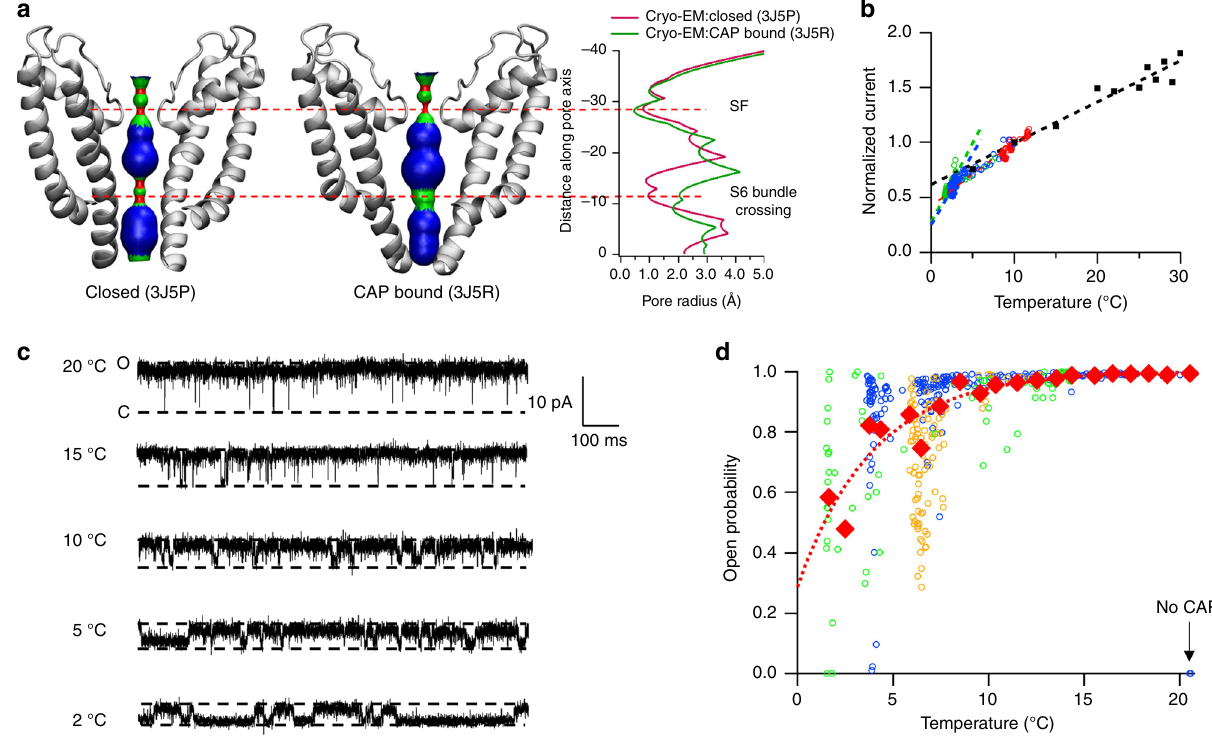
Fig. 1 TRPV1 closure induced by cooling in the presence of saturating concentrations of capsaicin. a Distribution of pore radii in the cryo-EM-derived closed state (3J5P) and capsaicin bound state (3J5R). The regions in red are too narrow to allow a water molecule to pass. The regions in green or blue are sites allowing single or multiple water molecules and ions to pass. Pore radii were calculated by the HOLE program 65 . SF, selectivity fi lter. b Temperature- dependent reduction of macroscopic current amplitude is steeper than that of single-channel conductance. Macroscopic currents from three inside-out patch recordings (shown in red, blue, and green) and single-channel current (shown in black) are normalized to the amplitude at 10 °C. Superimposed are linear fi ts of the single-channel conductance levels between 5 and 30 °C (black dashed line) or the macroscopic currents in the middle (red dashed line) and low (blue and green dashed lines) temperature ranges. c Example single-channel traces at representative temperatures in the presence of 10 μ M capsaicin. d Representative consecutive open probability measurements of three single-channel recordings (green, blue, and orange circles), as well as the average Po (red diamonds) fi tted to an exponential function (red dotted